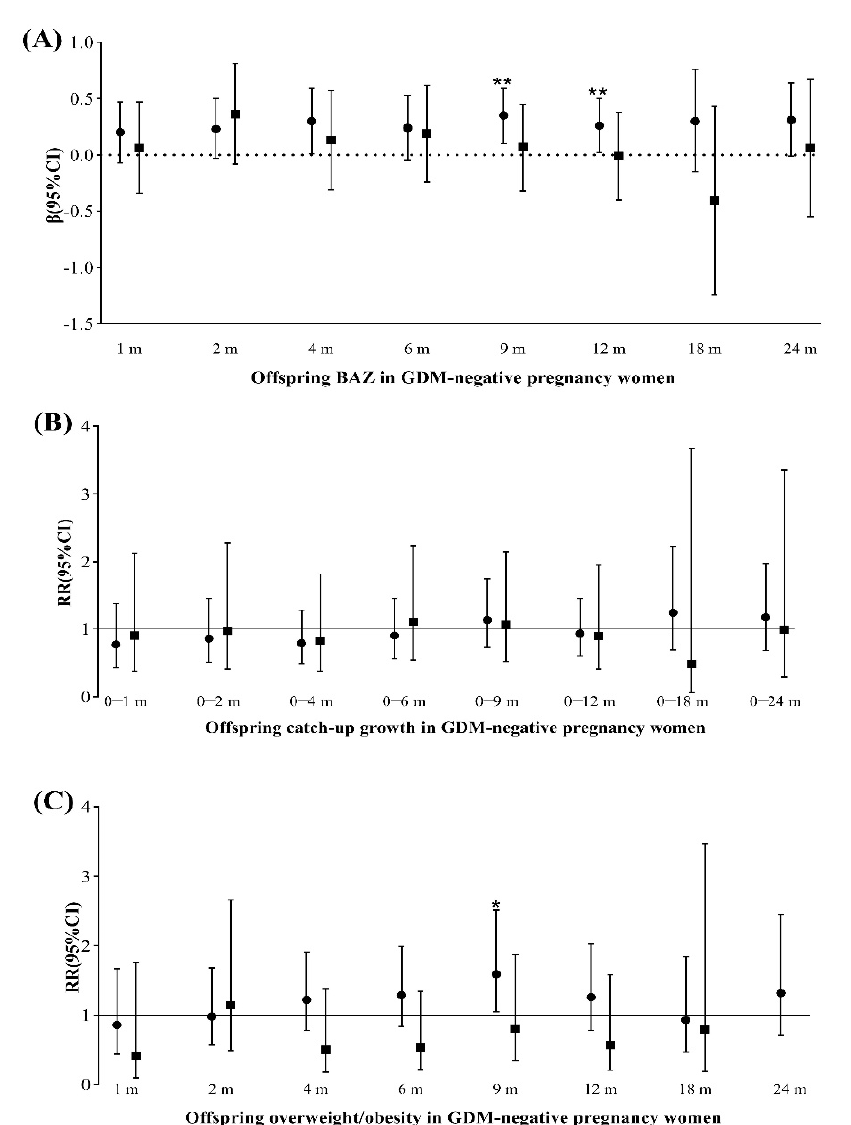
Figure 1. Forest plot of β /RRs with 95% CIs of anthropometric outcomes of 1- to 24-month-old offspring based on groups by maternal pre-pregnancy BMI and third-trimester FPG among GDM-negative women. ( A ) Offspring BAZ in GDM-negative pregnancy women; ( B ) Offspring catch-up growth in GDM-negative pregnancy women; ( C ) Offspring overweight/obesity in GDM-negative pregnancy women. Circles show G2 vs. G1: overweight/obesity with pre-BMI and third-trimester FPG being controlled vs. normal pre-BMI and third-trimester FPG being controlled. Squares show G3 vs. G1: normal pre-BMI and third-trimester FPG not controlled vs. normal pre-BMI and third- trimester FPG being controlled. Because the G4 group had fewer people at different months of age, no analysis was made. ** p < 0.01, * p < 0.05. Model 1 for offspring birth weight, Model 2 for offspring BAZ, BAZ catch-up growth, Model 3 for offspring overweight/ obese. Model 1: adjusted for: sex, age at delivery, gestational weight gain, education, family income, parity, delivery mode, PA level, energy intake, anxiety and depression in the third trimester, maternal smoke or alcohol during pregnancy, gestational age at delivery Model 2: adjusted for covariates in Model 1 + mode of infant feeding within the first six months (exclusive breastfeeding, mixed feeding, exclusive formula feeding), breast feeding duration. Model 3: adjusted for covariates in Model 2+ Birth weight